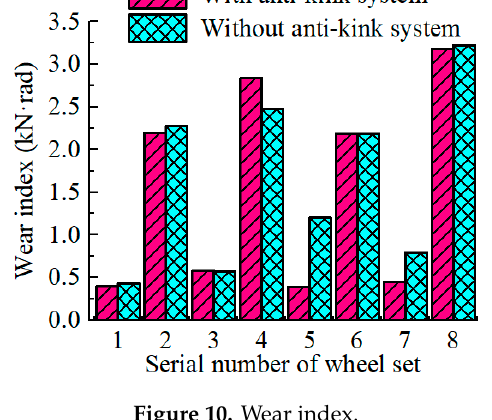
Figure 10. Wear index.